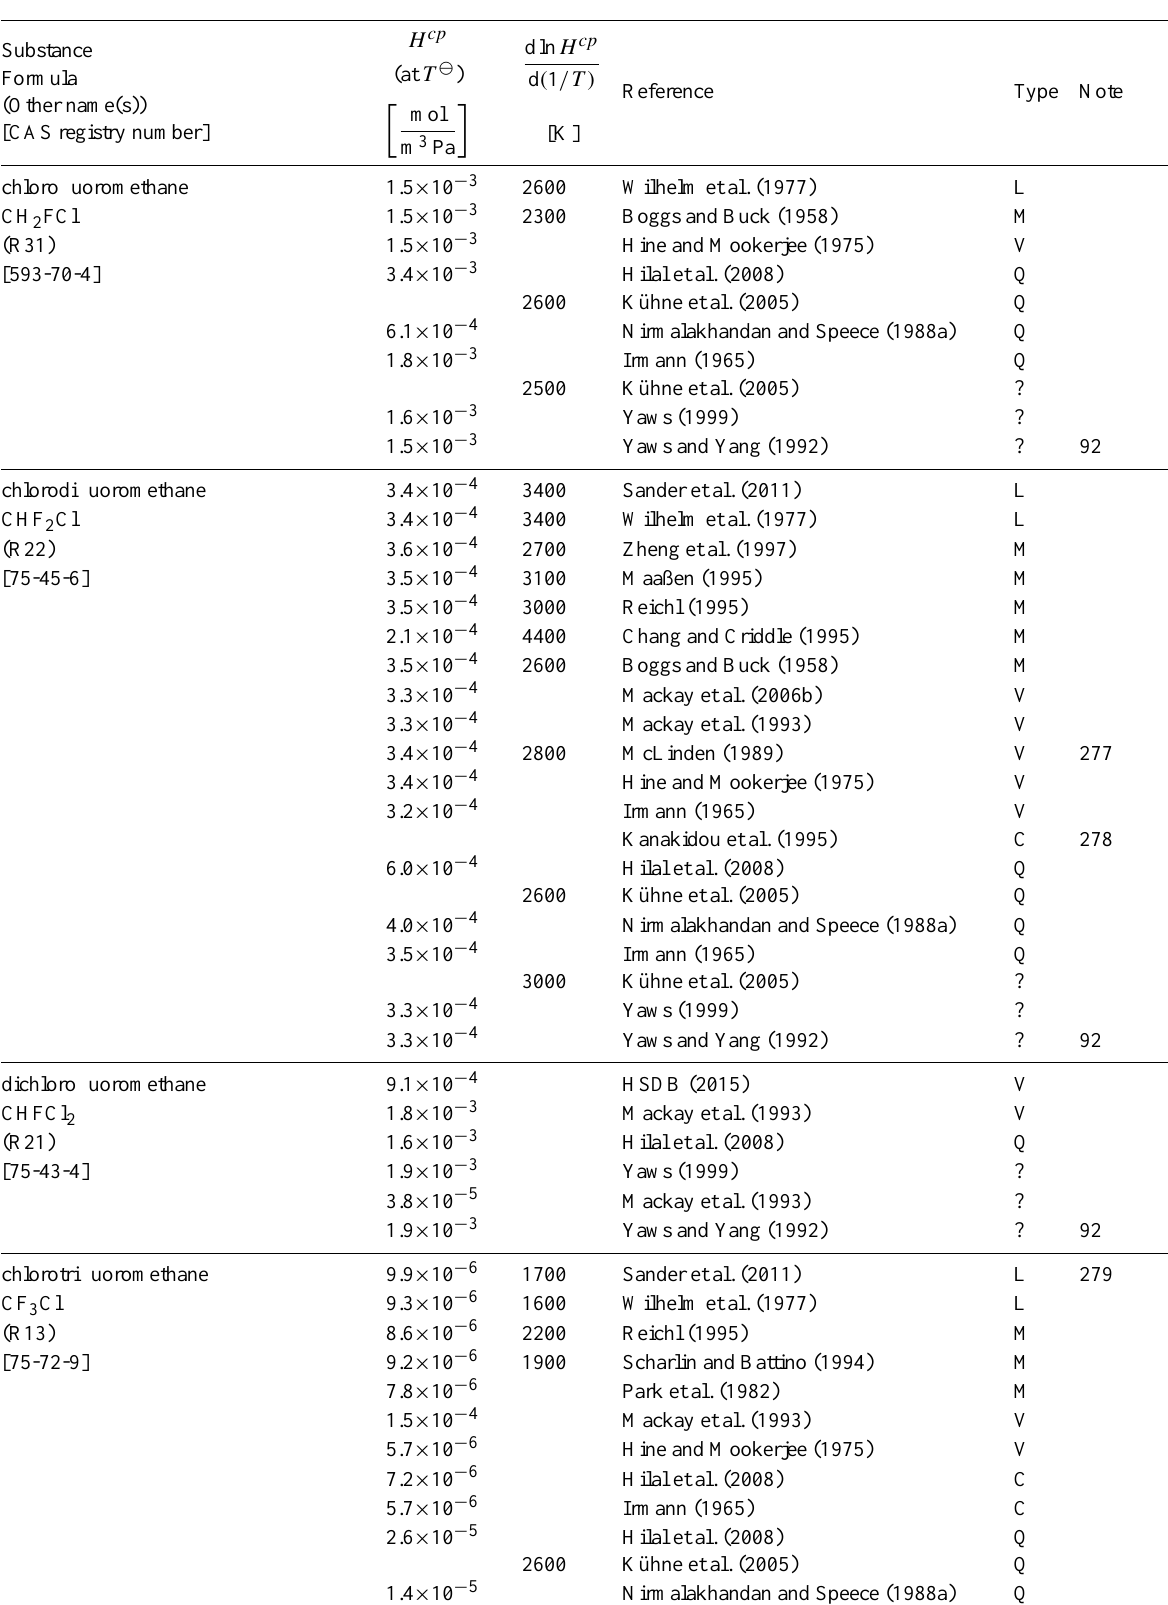
Table 6: Henry’s law constants for water as solvent